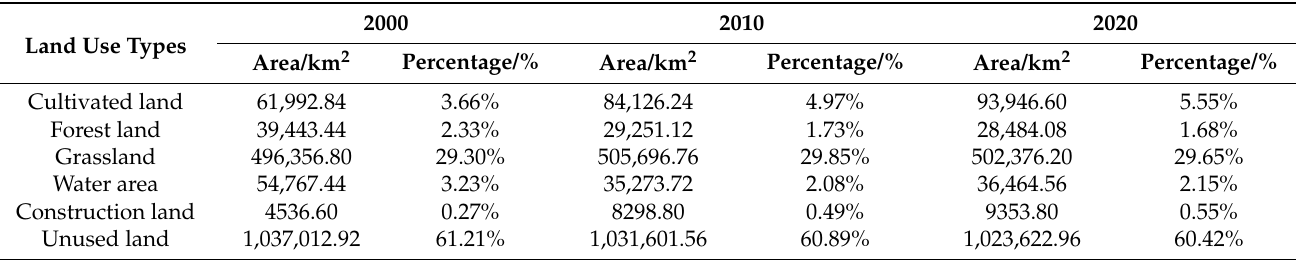
Table 2. Land use situation in Xinjiang in 2000, 2010, and